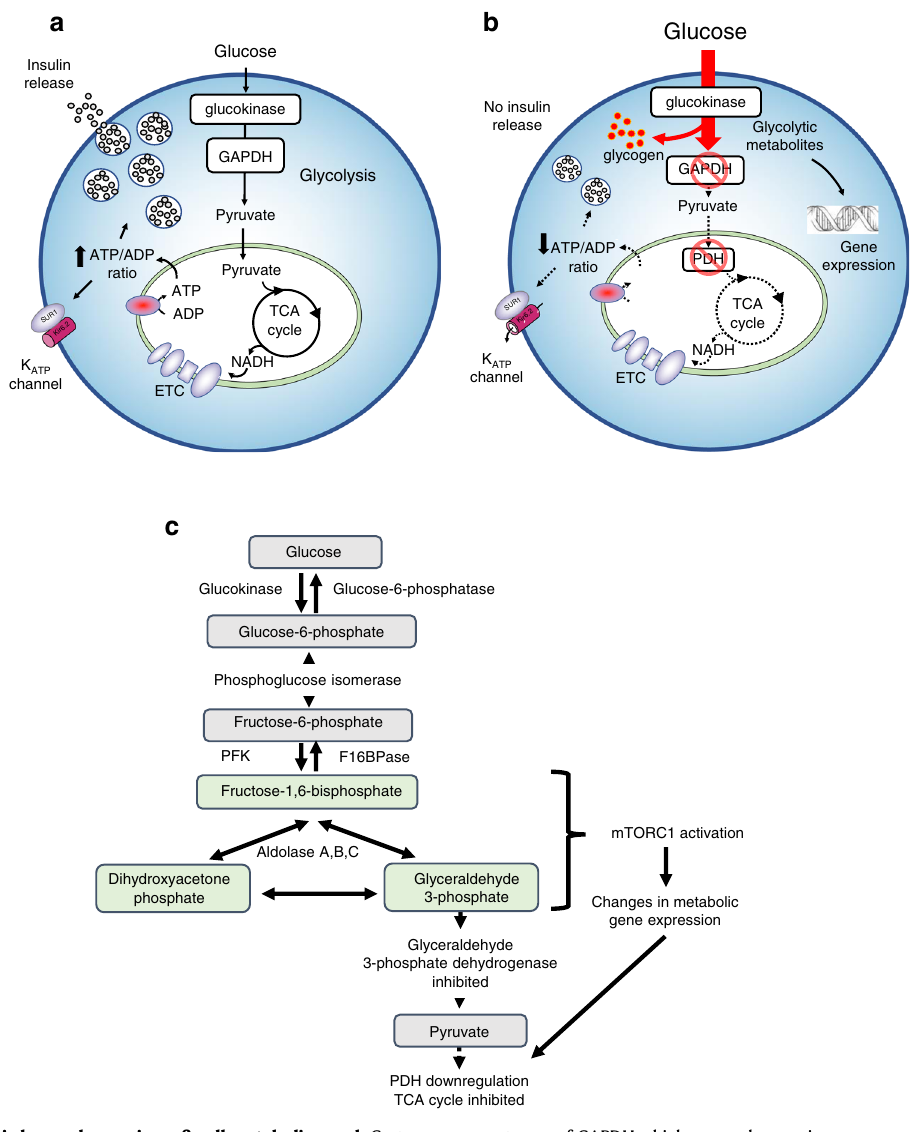
upstream of GAPDH which cause changes in gene expression that downregulate PDH and GAPDH activity further. Because metabolism is reduced, glucose- dependent changes in the ATP/ADP ratio, K ATP channel activity and insulin secre- tion are impaired. The enhanced activity of glucokinase also leads to a build-up of G6P which is channelled into glycogen. c Schematic of glycolysis showing the metabolic steps (highlighted) implicated in mTORC1 activation and consequent changes in metabolic gene expression. Metabolic steps that are inhibited are also